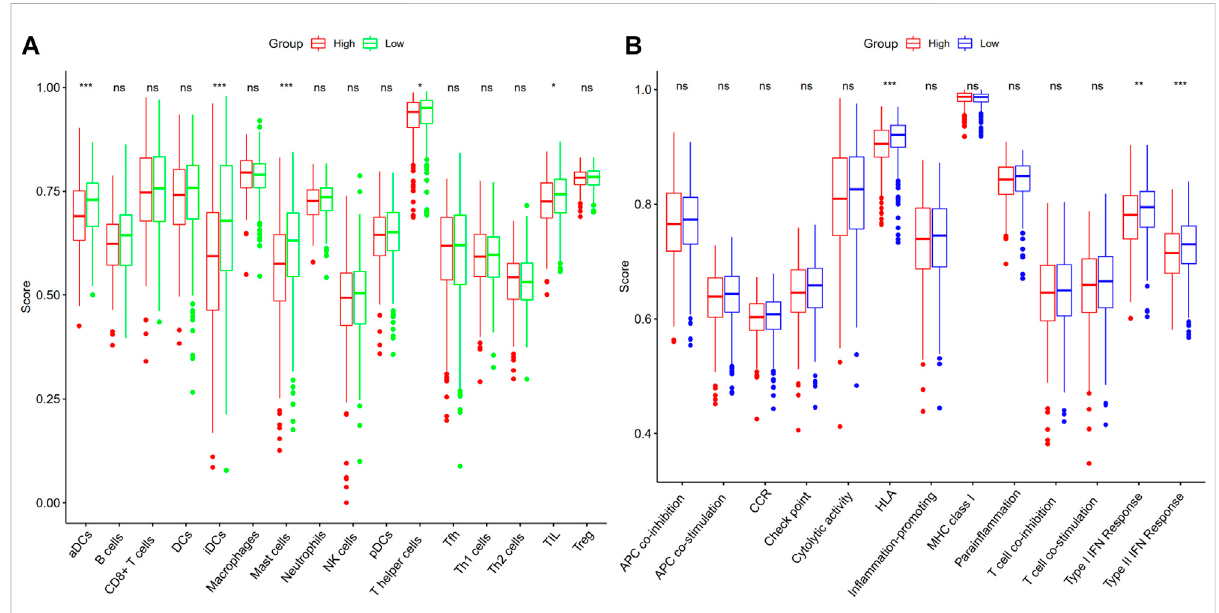
FIGURE 6 ssGSEA score comparison for immune cells and immune pathways. (A) Comparison of the enrichment values of 16 different kinds of immune cells in the TCGA dataset between patients at high (red box) and low risks (green box). (B) Patients in the high-risk (red box) and low-risk (blue box) groups in the TCGA cohort were compared on the basis of the enrichment values of 13 distinct immune-associated pathways. iDCs, immature dendritic cells; aDCs, activated dendritic cells; TIL, tumor-in fi ltrating lymphocyte; DCs, dendritic cells; IFN, interferon; NK cells, natural killer cells;MHC,majorhistocompatibility complex; Th1cells, type1Thelpercells;Tfh,Tfollicularhelpercell;Th2cells, type2Thelpercells;APC, antigen